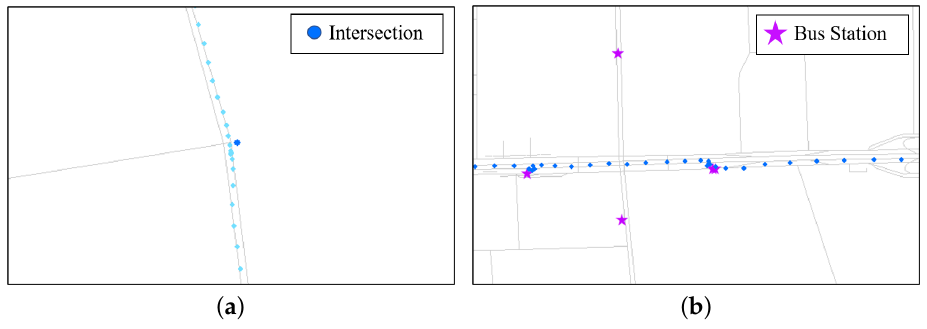
Figure 3. The influence of road intersections and bus stations. ( a ) A car trajectory affected by a road intersection. ( b ) A bus trajectory affected by a bus